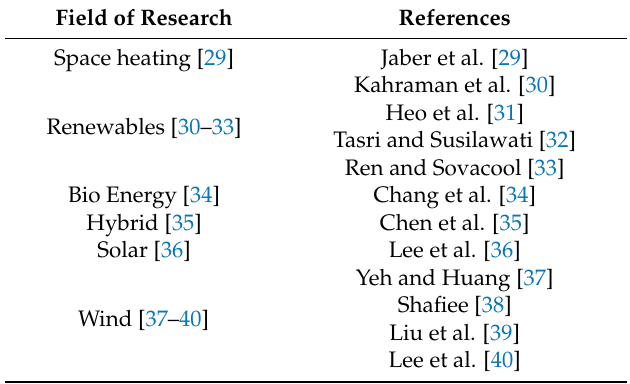
Table 2. Applications of FAHP as MCDA technique in previous renewable energy